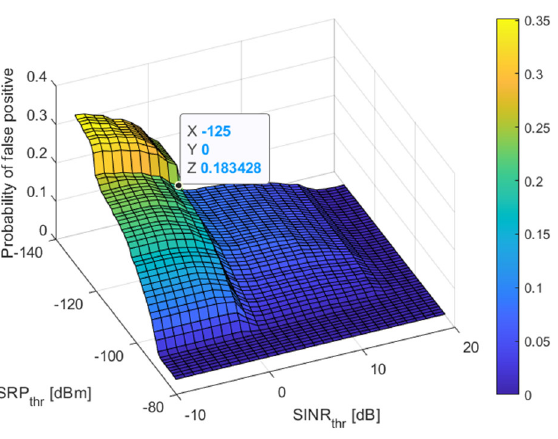
Figure 7. The probability of false positive decision for different threshold values for RSRP and SINR while the threshold for RSRQ was set to −20 dB and the threshold for RSSI was set to −114 dB.